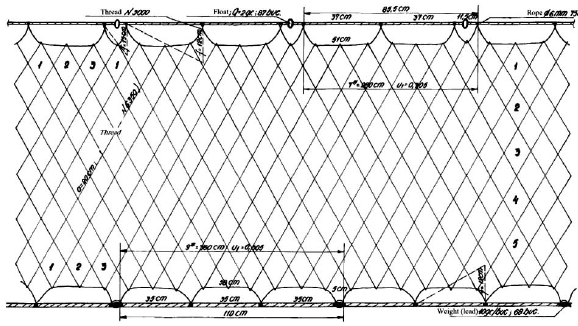
Fig. 1. – Turbot gillnet - hanging